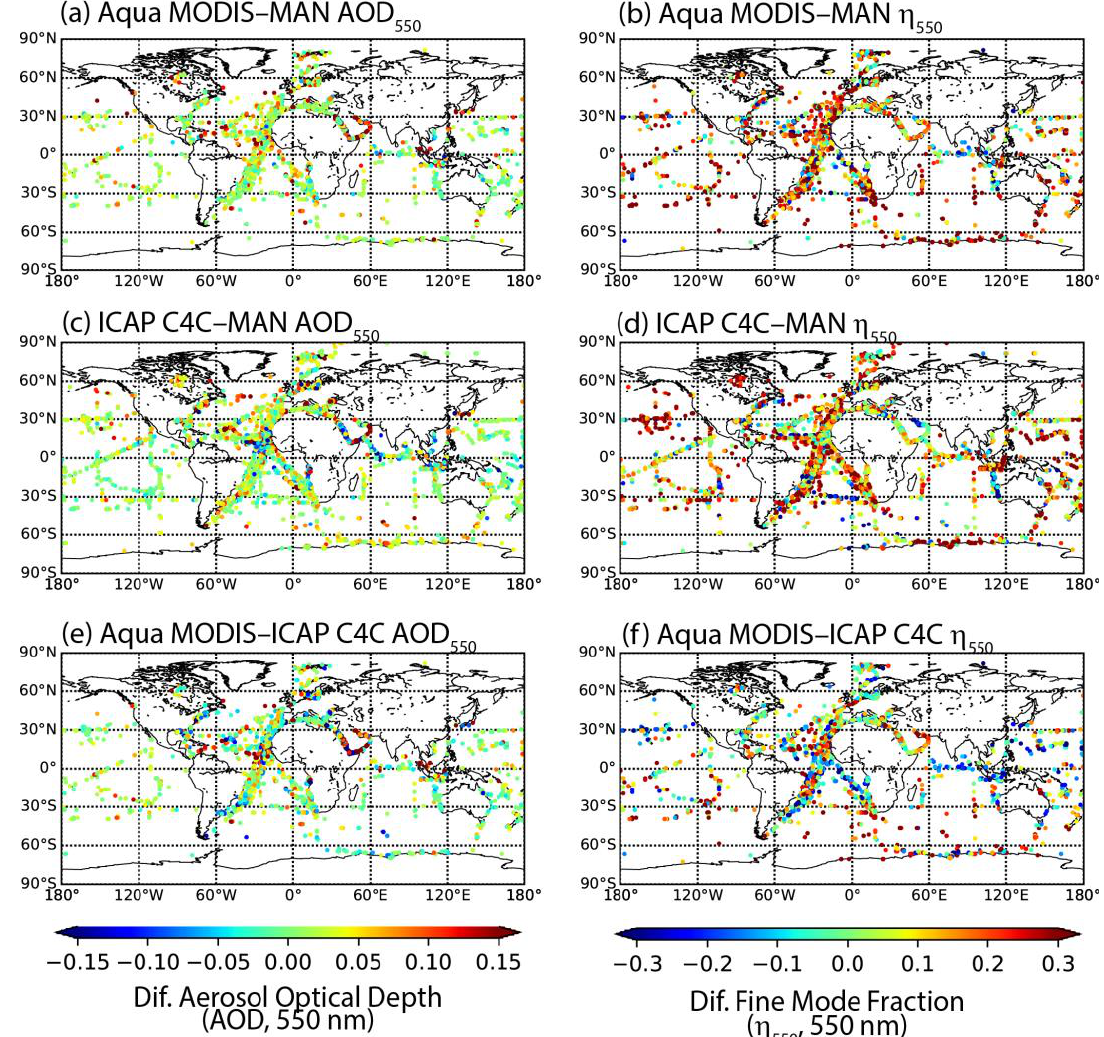
Figure 6. Differences between total AOD 550 and η 550 for products provided in Figure 5. Included are ( a , b ) Aqua MODIS minus MAN, ( c , d ) ICAP C4 minus MAN, and ( e , f ) Aqua MODIS minus ICAP C4.